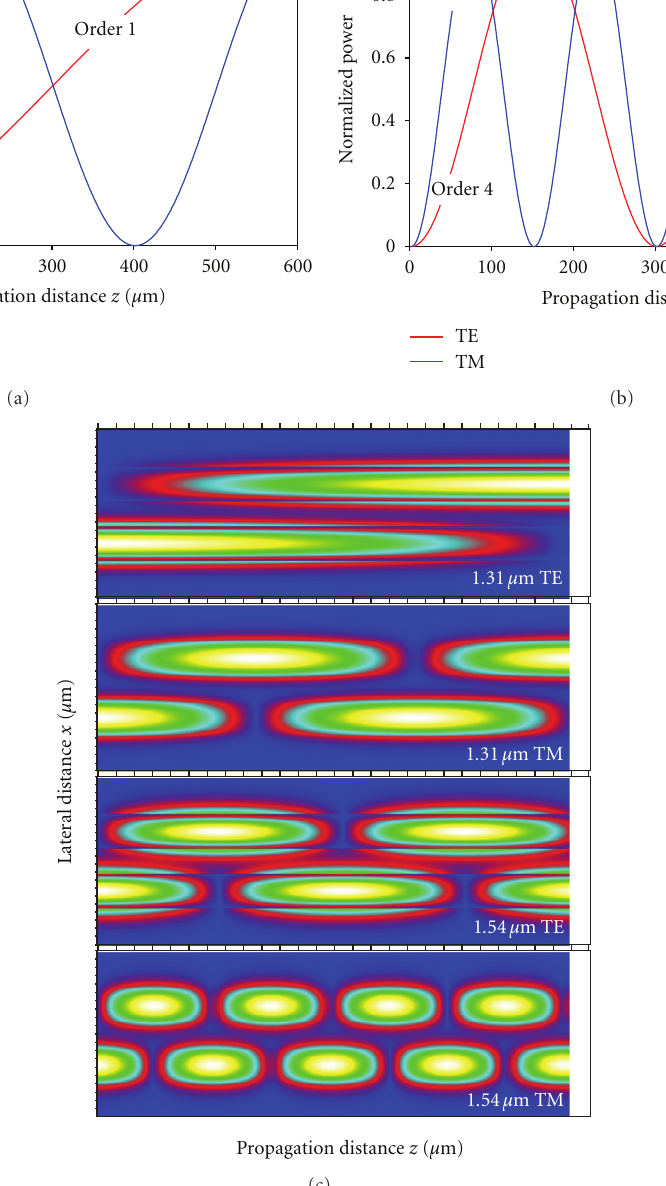
Figure 6: Simulated power in the cross waveguide for TE and TM polarizations of (a) λ = 1.31 μ m, (b) λ = 1.54 μ m, and (c) the corresponding field profiles along the directional